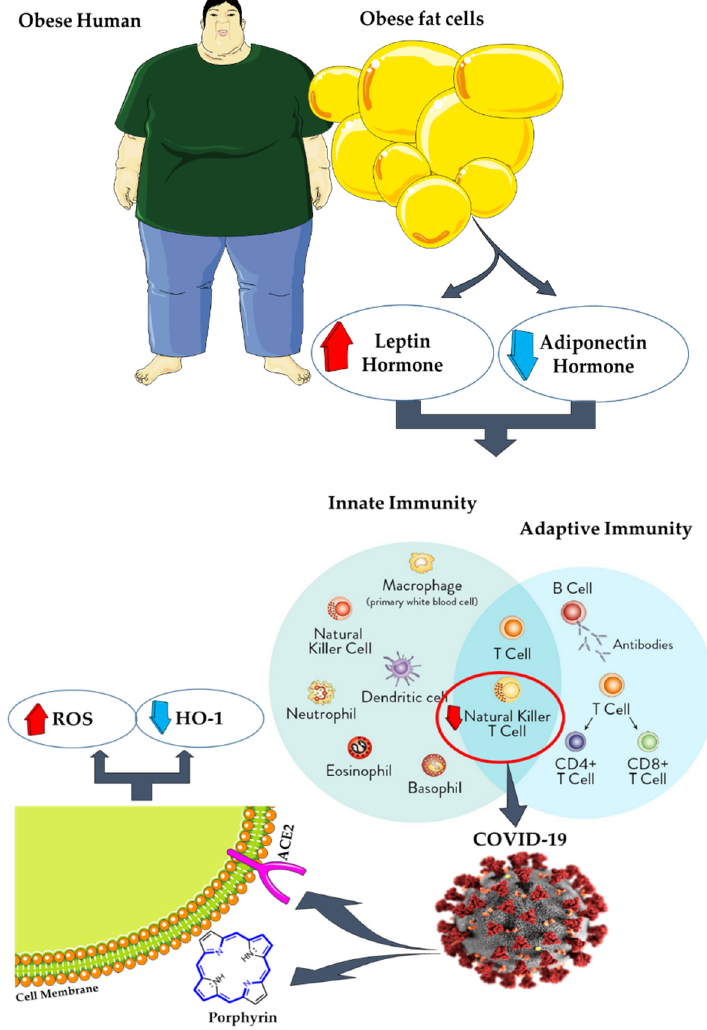
Figure 2. During obesity, adipose tissue (ATs) function is impaired, and secretion of leptin and adiponectin increases and decreases, respectively. Moreover, the immune system’s function is impaired. One of the consequences of an impaired immune system is the induction of viral infections such as COVID-19 due to reduced natural killer (NK) cell activity. COVID-19 requires binding to the Angiotensin-Converting Enzyme 2 (ACE2) receptor and porphyrins on the cell surface to enter and then infect fat cells. Eventually, heme oxygenase-1 (HO-1) and ROS levels decrease and increase, respectively [109–113].